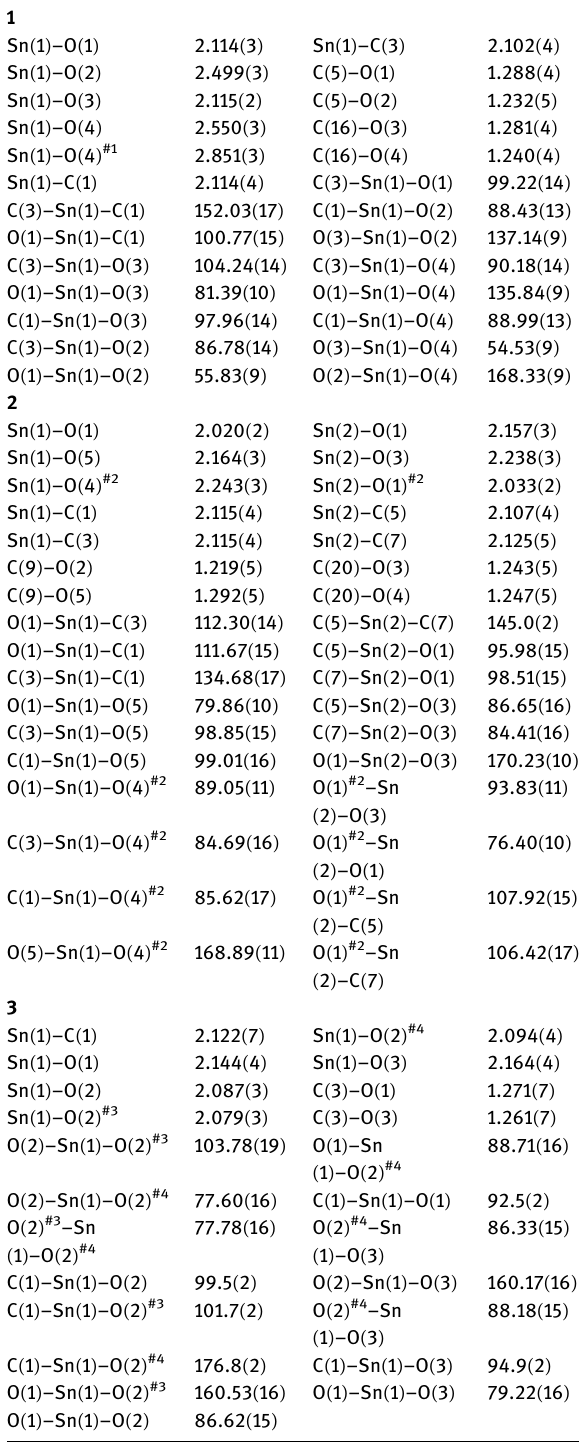
Table 1: Selected bond lengths ( Å ) and angles ( ° ) for 1 –